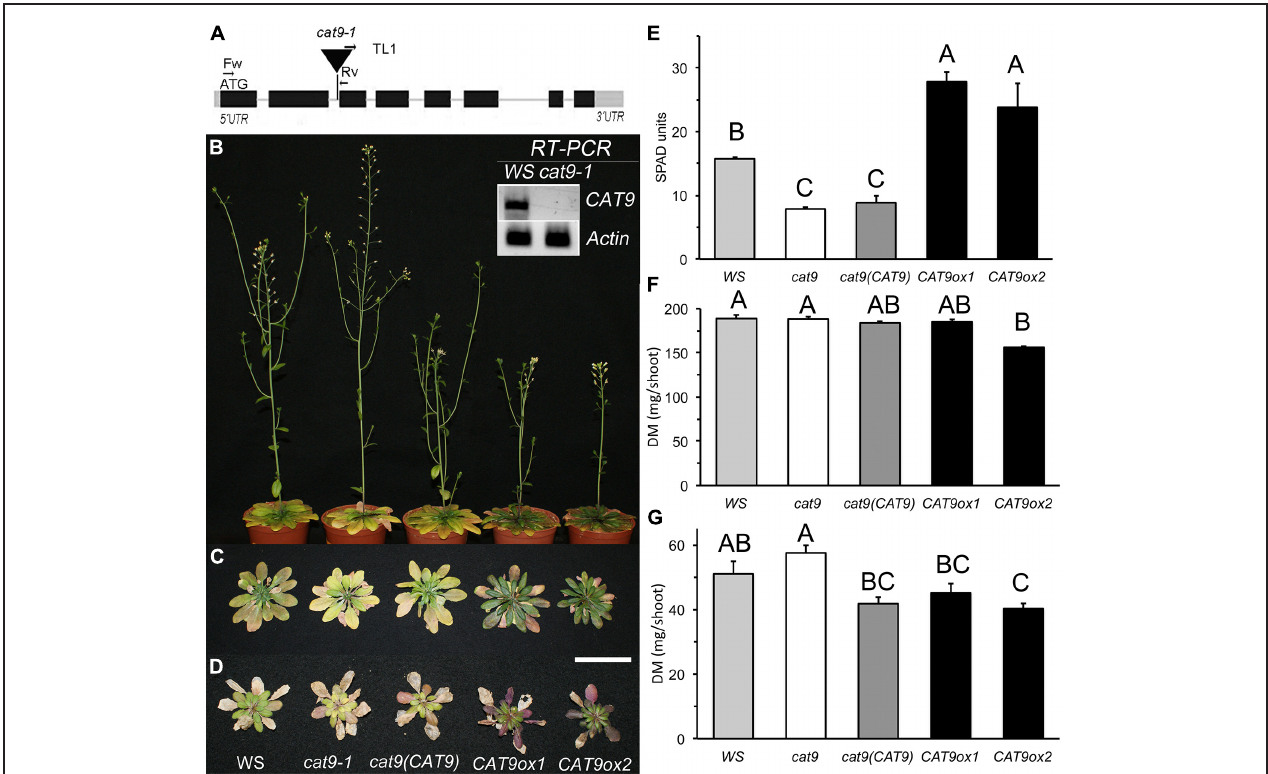
FIGURE 5 | Identification of knock-out and over-expression lines for CAT9 and their growth characteristics on soil. (A) Schematic view of CAT9 genomic structure (2823 bp). Black squares: exons, gray squares: untranslated regions. The T-DNA insertion was localized in the second intron. Inset: total loss of CAT9 transcript in the homozygous cat9-1 mutant. Actin2 served as a control. (B) Nine-week old plants on fertilized soil at flowering, from left to right: Wassilewskija ( WS ) wild type, cat9-1 , cl cat9 ( CAT9 ) and